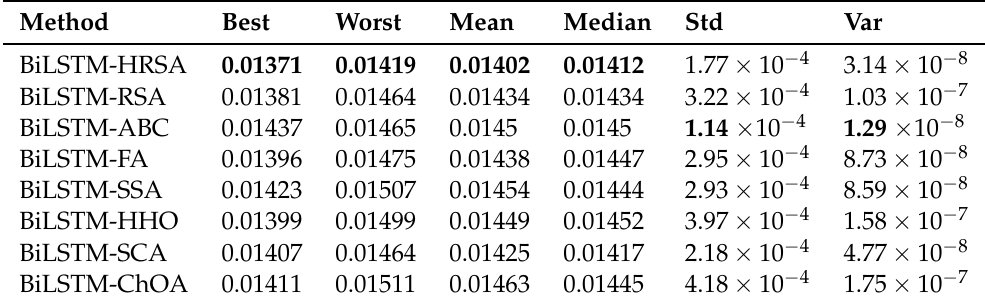
Table 5. Overall results of the objective function for BiLSTM experiments. The best result in each column is written in bold.